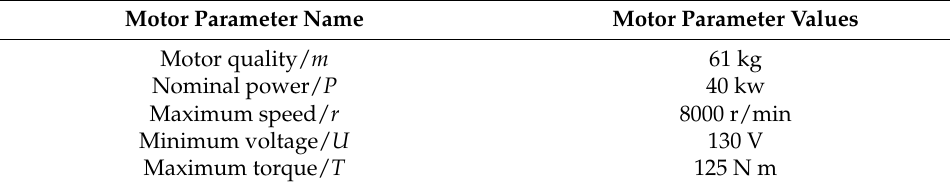
Table 5. Motor parameters.